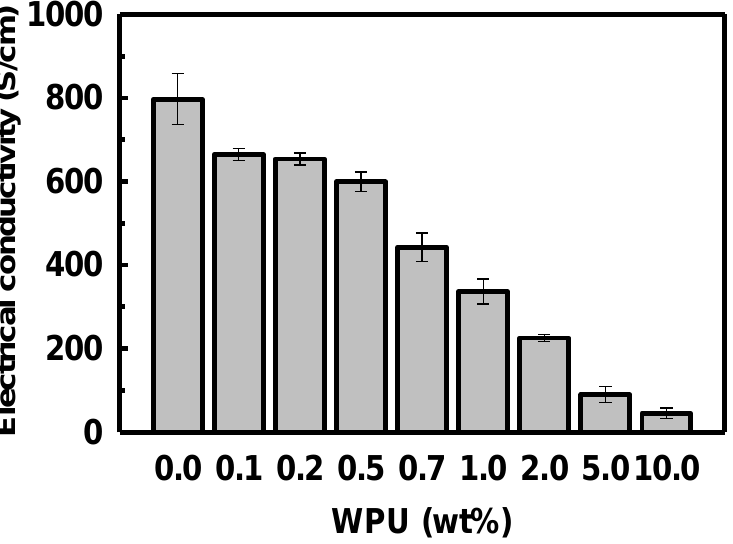
Figure 6. Electrical conductivity of PEDOT:PSS/nonionic WPU with various proportions of WPU in the PEDOT:PSS solution.